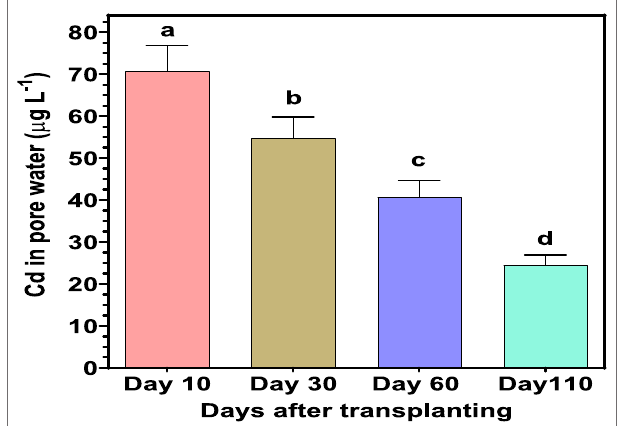
FIGURE2 | Reduction oftotal Cd concentrationin pore waterover time. Levels not connected by the same letter are signi fi cantly different ( p < 0.001). Data are mean ± SE (standard error).